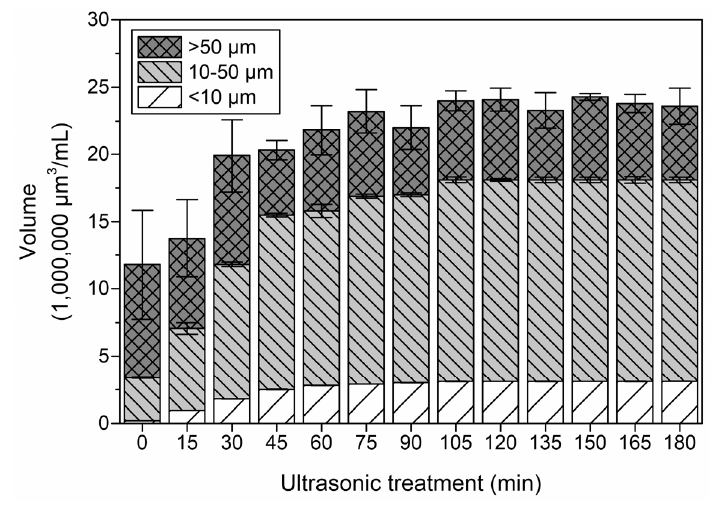
Figure 6. Calculated volume of batch A during ultrasonic treatment. Particles were grouped in size fractions < 10, 10–50, and > 50 µ m (please note: di ff erent fractions were chosen for volume fractions compared to number fractions). Error bars show standard deviation of n = 3.